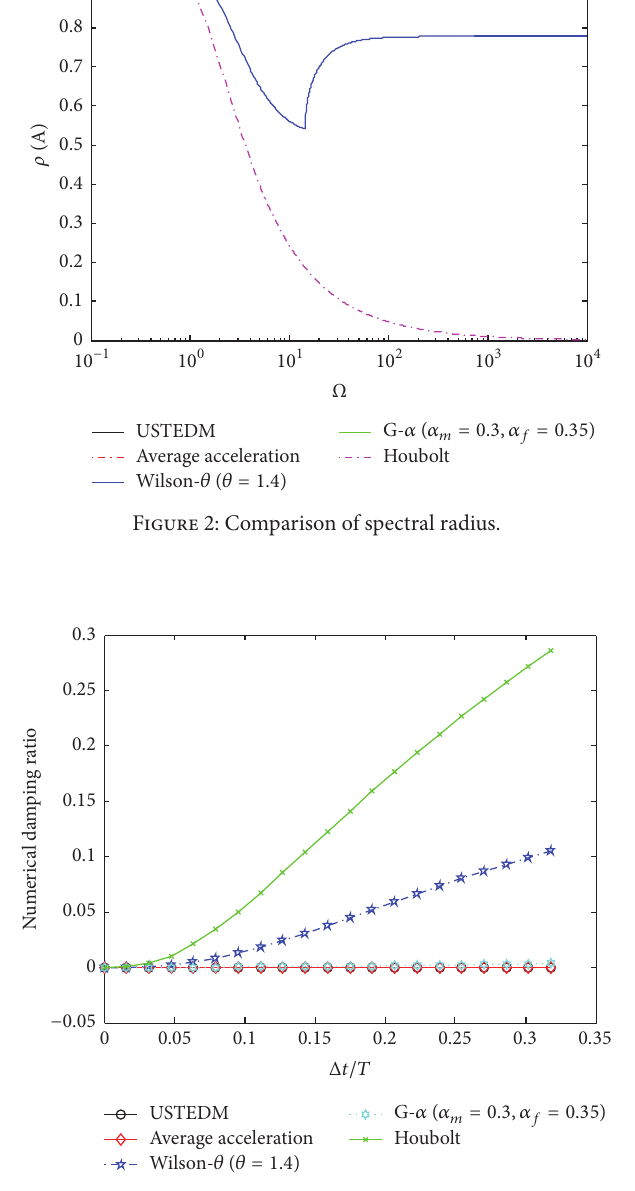
Figure 3: Comparison of numerical damping ratio.